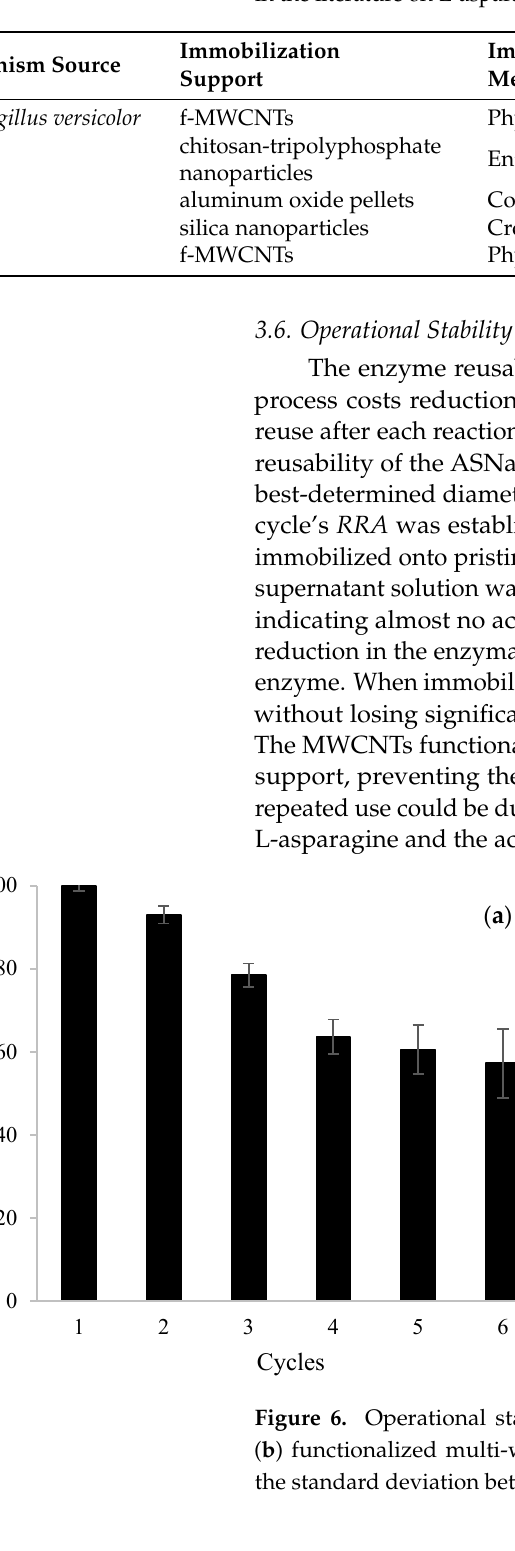
Table 3. Comparison of immobilization yield ( IY ) and relative recovered activity ( RRA ) values reported in the literature on L-asparaginase (ASNase) immobilization with those obtained in this work.